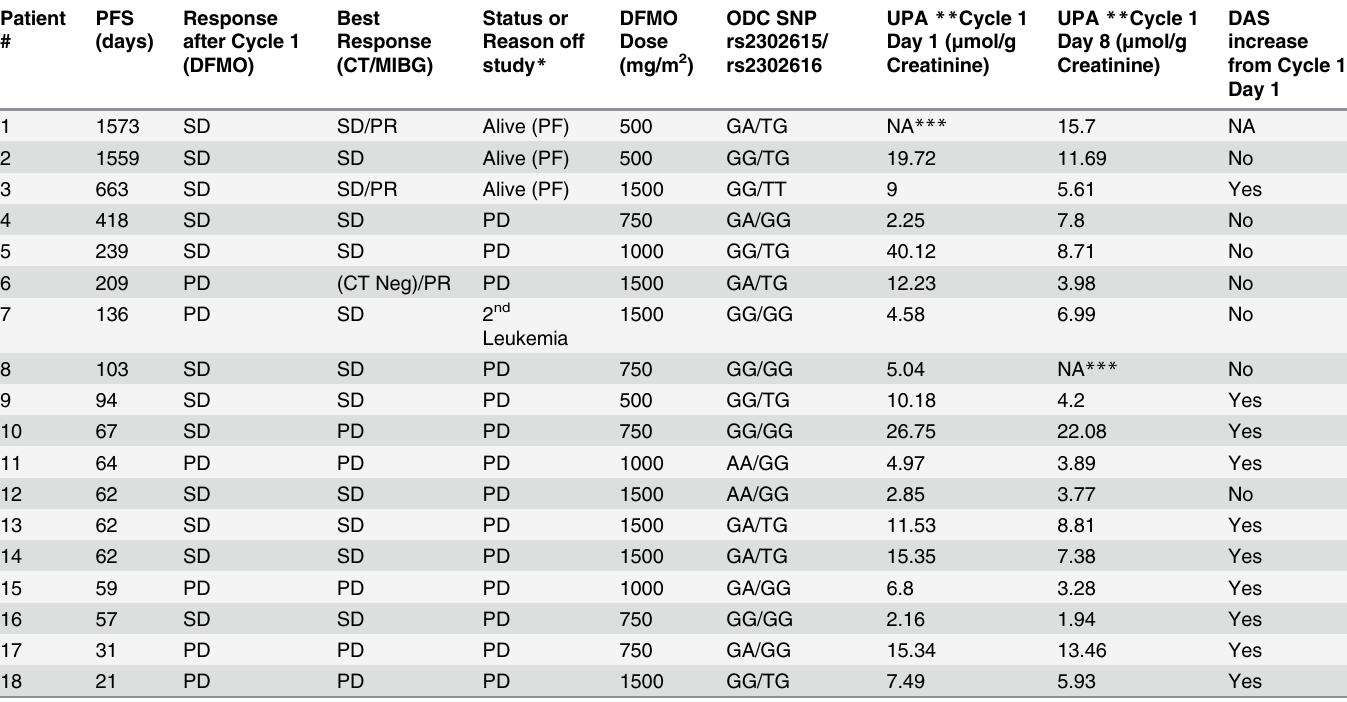
Table 5. Rank-ordered PFS by DFMO dose, ODC genotype and urinary polyamines.